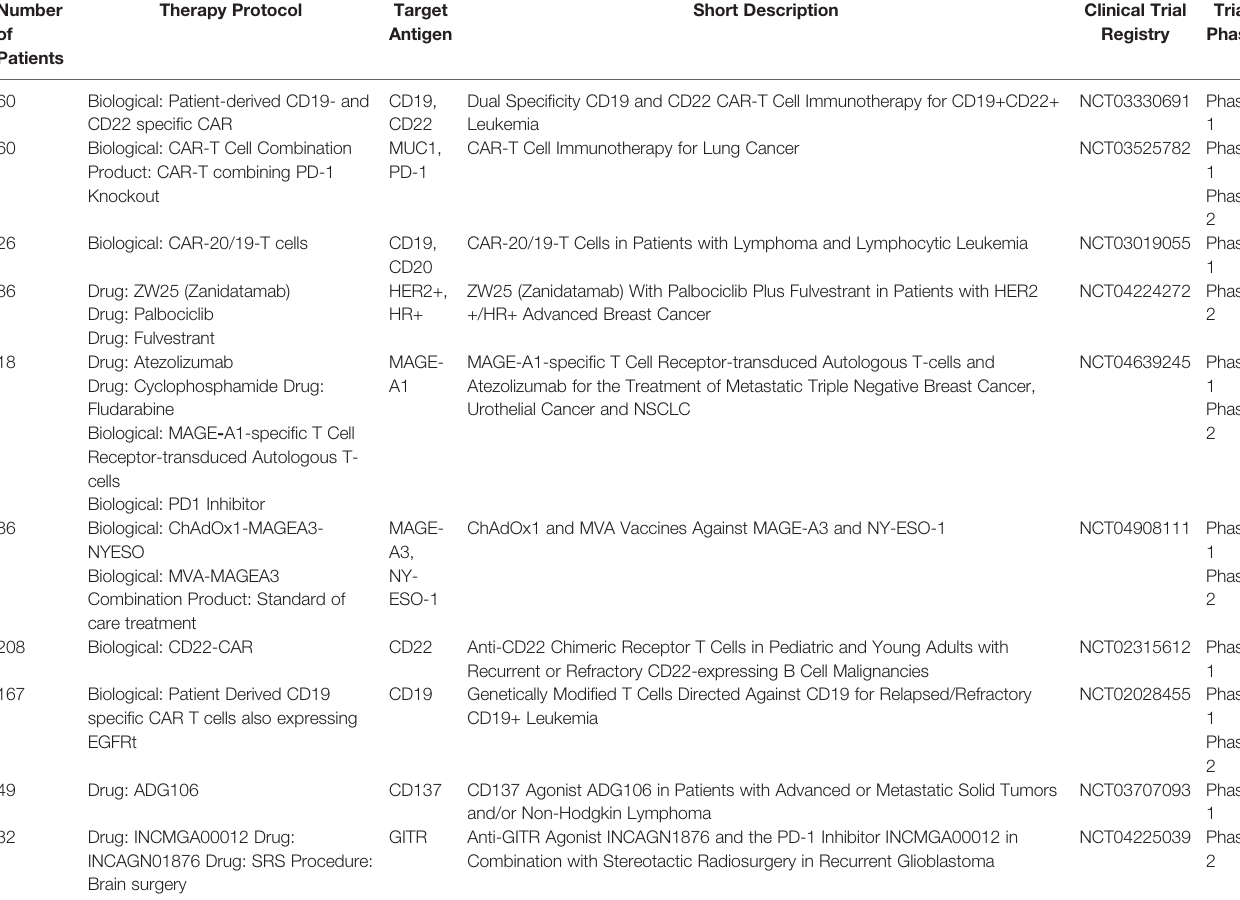
TABLE 2 | Active clinical